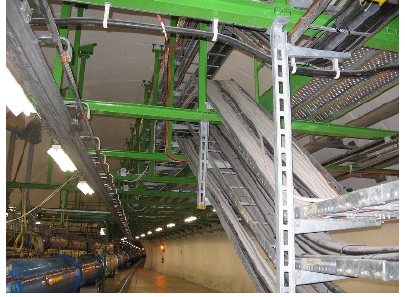
Figure 2. An instance of MEP systems.